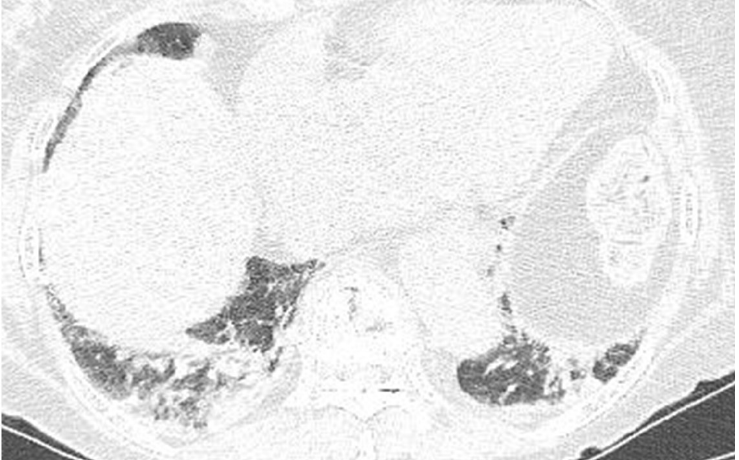
Figure 2. A 76-year-old woman with acute phlegmonous esophagitis. Lung window of an axial CT image at the liver dome level shows peri-bronchial ground-glass opacities and consolidations in both lower lobes.